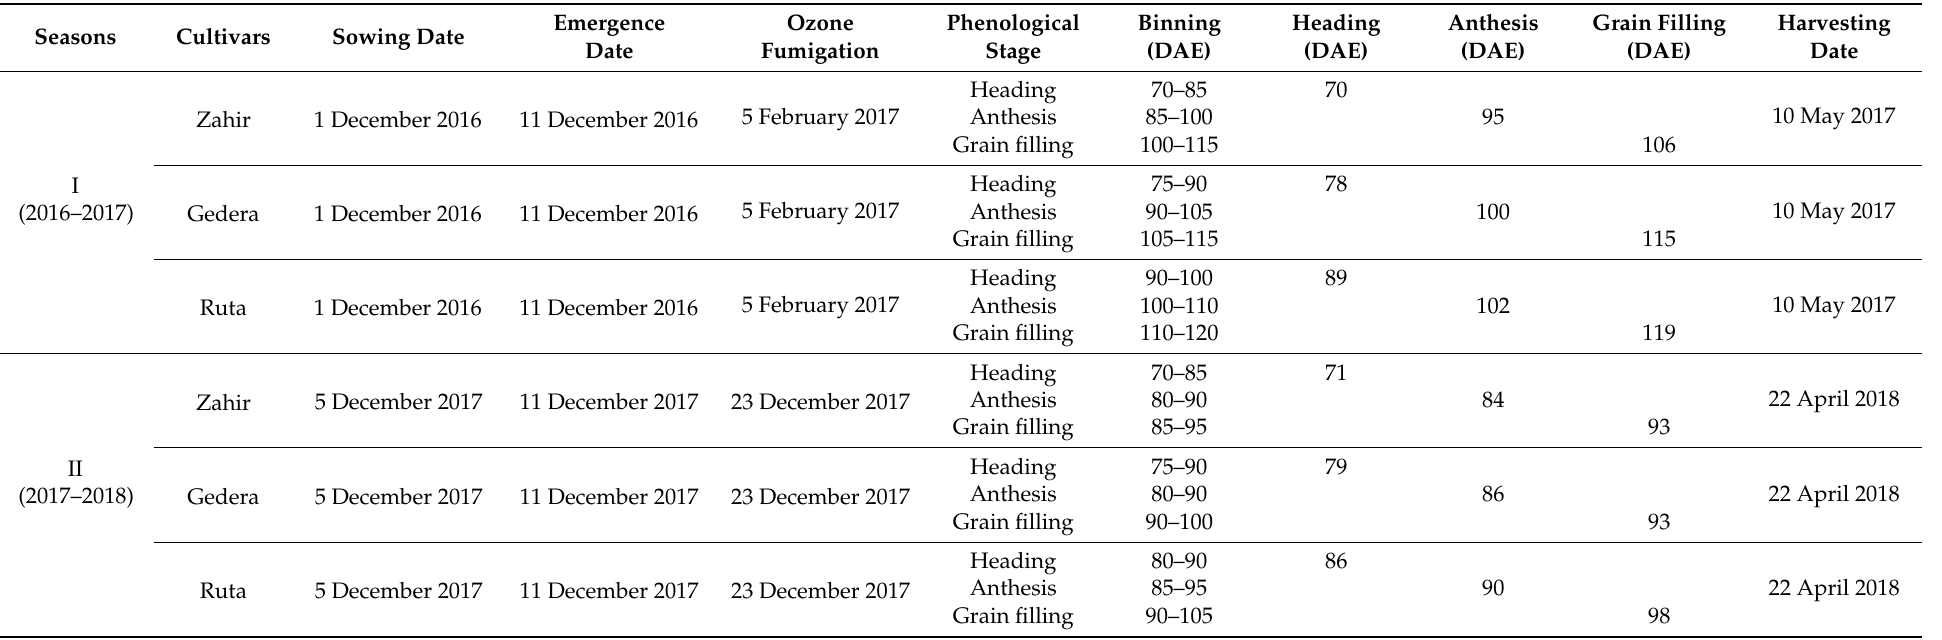
Table 2. OTC experimental setup. Crop phenology, initiation of O 3 exposure, and